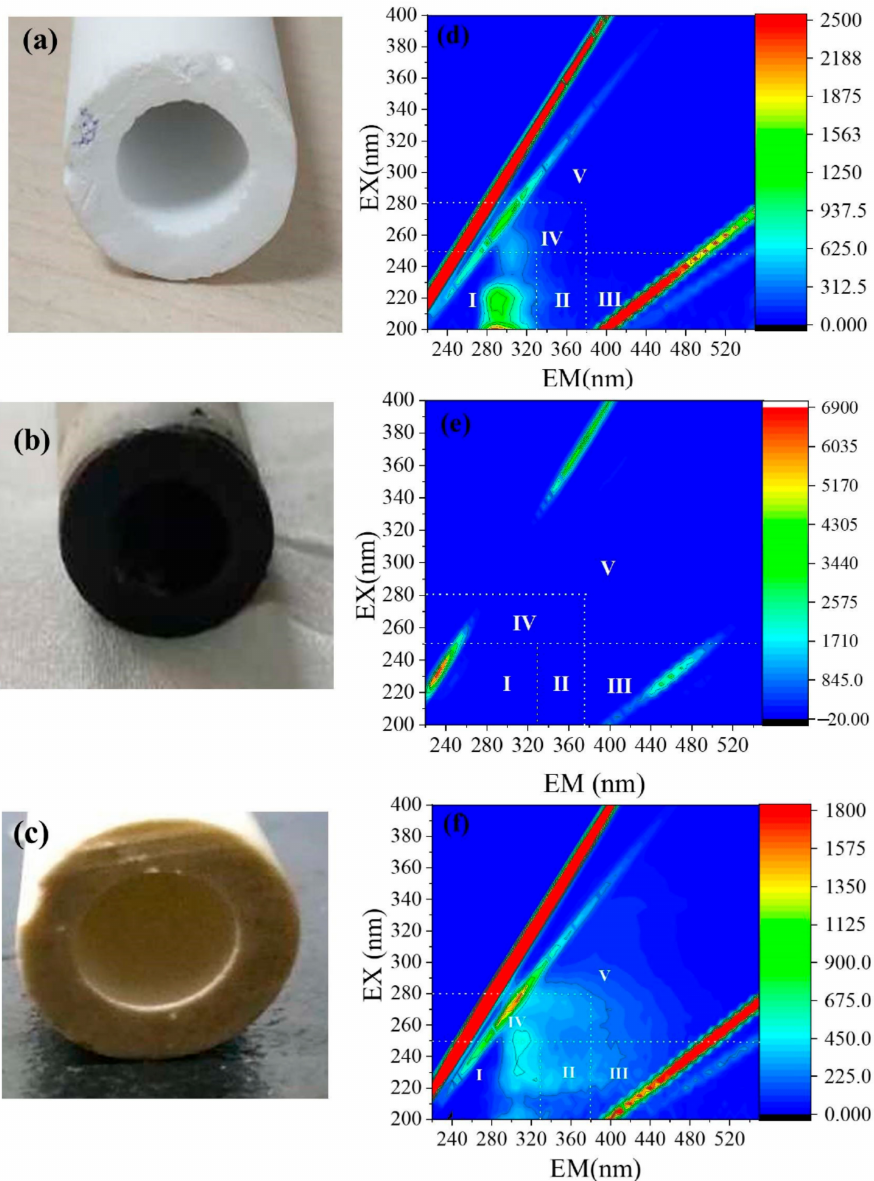
Figure 1. The evolution of the physical appearance of the ceramic tubular membrane and the biopolymer composition of membrane cleaning solutions ( a ) Virgin membrane ( b ) fouled membrane ( c ) cleaned membrane ( d ) permeate cleaning solution ( e ) NaOCl cleaning solution ( f ) citric acid cleaning